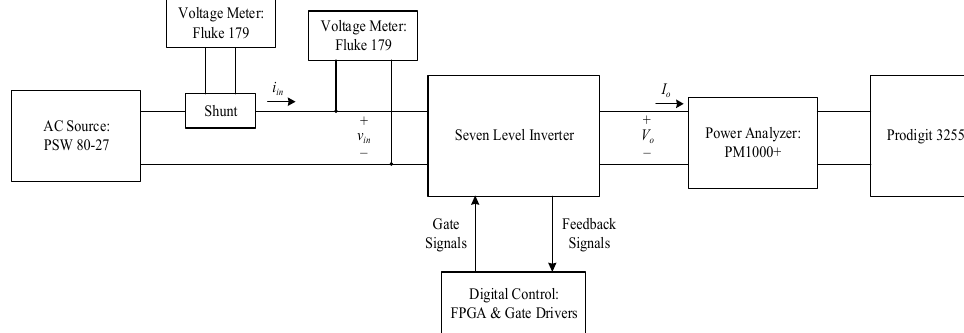
Figure 20. Block diagram of efficiency measurement.